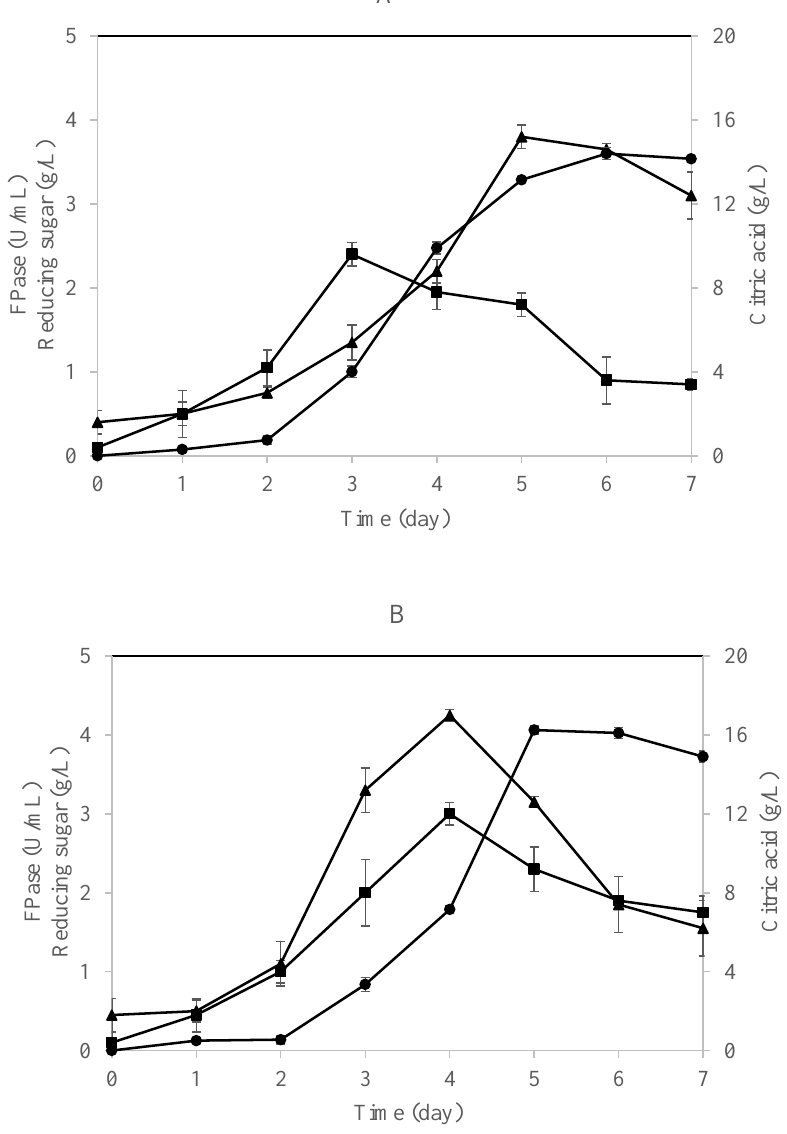
Figure 1. Schematic diagram of the two-stage process for simultaneous cellulase enzyme and citric acid production employing loofa sponge-packed column bioreactors. A: Air filters; B: Glass wool depth filter.